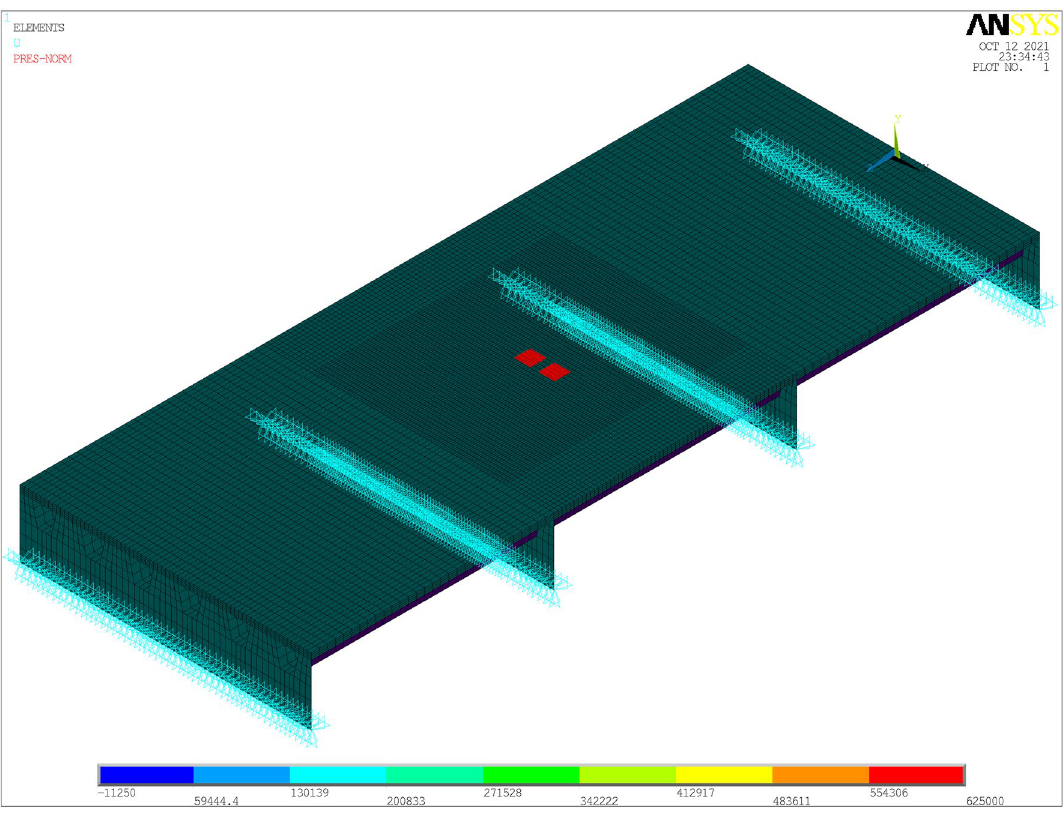
Figure 2. The EF model of OSD pavement structure (Unit: